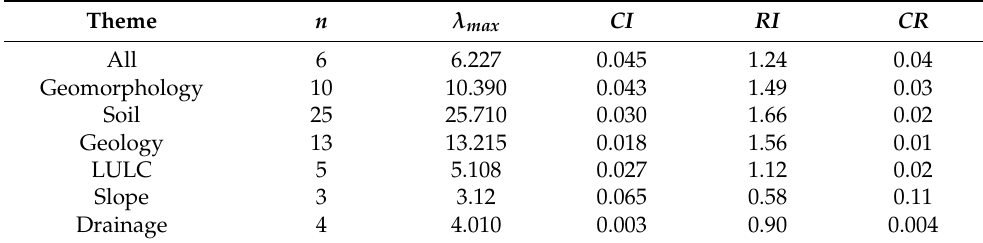
Table 3. The number of themes and features ( n ), the largest eigenvalue of pairwise comparison judgment matrix ( λ _max ), consistency index ( CI ), random consistency index ( RI ), and consistency ratio (CR) for the selected criteria to delineate the GWPZ.